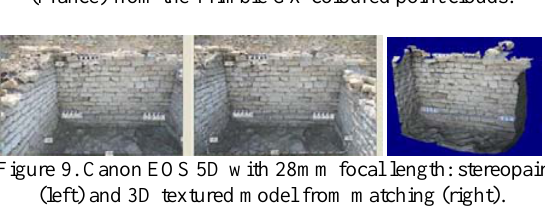
Figure 8. Overall view of the Gallo-roman Theatre of Mandeure (France) from the Trimble GX coloured point clouds.